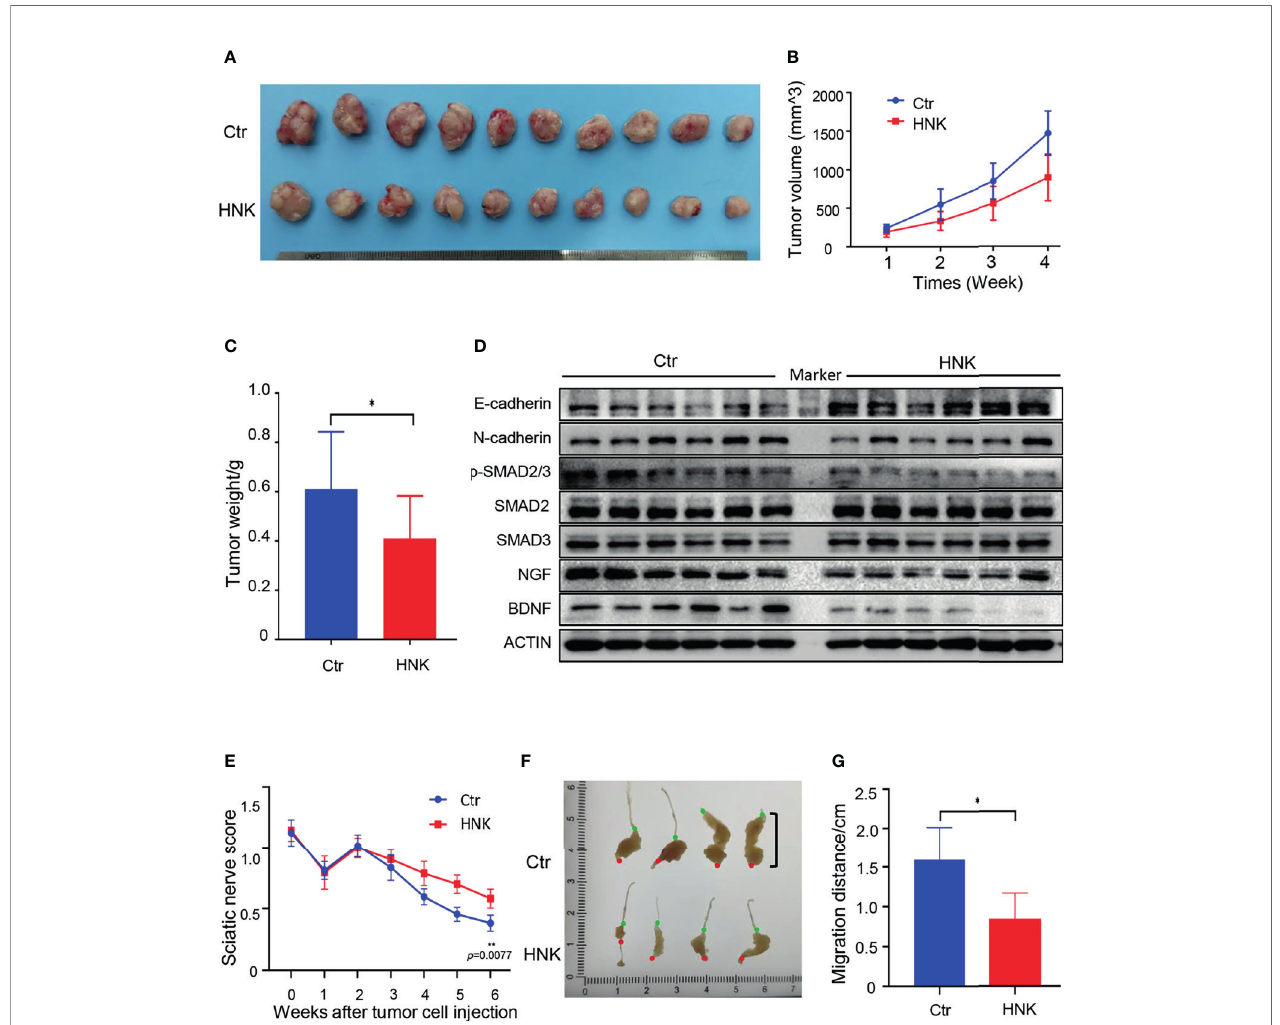
FIGURE 6 | HNK inhibits EMT and perineural invasion in vivo . (A) Photographs of tumors in the subcutaneous pancreatic cancer model. (B) Tumor volumes were measured every week. (C) Tumor weights after sacri fi cing mice in the subcutaneous pancreatic cancer model. (D) Western blotting analysis of the expression of E-cadherin, N-cadherin, NGF, BDNF, and the activity of p-SMAD2/3 in tumor tissues. (E) The sciatic nerve function index in the sciatic nerve invasion model. (F) Photographs of tumors in the sciatic nerve (red dot: the injection point; green dot: the forefront of tumor cells). (G) Migration distances of tumors along the sciatic nerve were measured (from the injection point to the forefront of tumor cells). * p < 0.05, ** p <